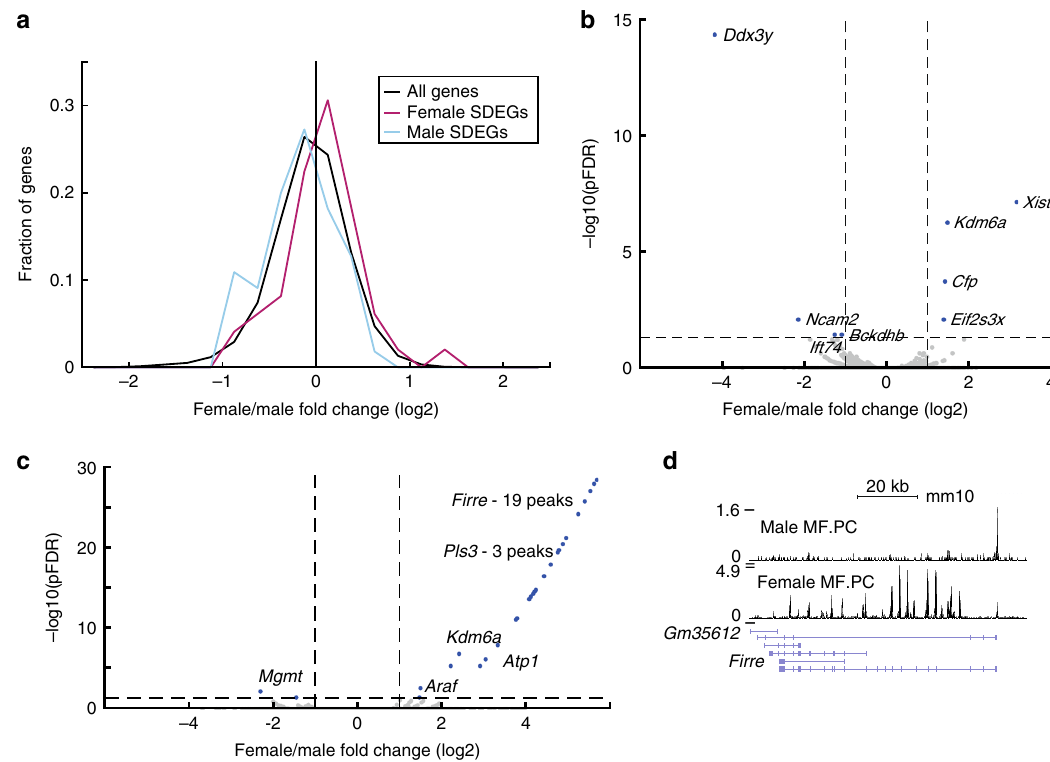
Fig. 5 ATAC-seq data of MFs display sexual dimorphism in chromatin accessibility. a Female – male fold change (log 2 gene body OCR value) distribution of MF-speci fi c female (pink) and male (blue) SDEGs and all other genes (termed all genes, excluding SDEGs, black). b Sexual differential accessibility in macrophage TSS OCRs (adjusted two-sided t test pFDR < 0.05 and female – male fold change >2, shown in blue). c Sexual differential accessibility in macrophage distal enhancer OCRs (adjusted two-sided t test pFDR < 0.05 and female – male fold change >2, shown in blue). d The Firre locus